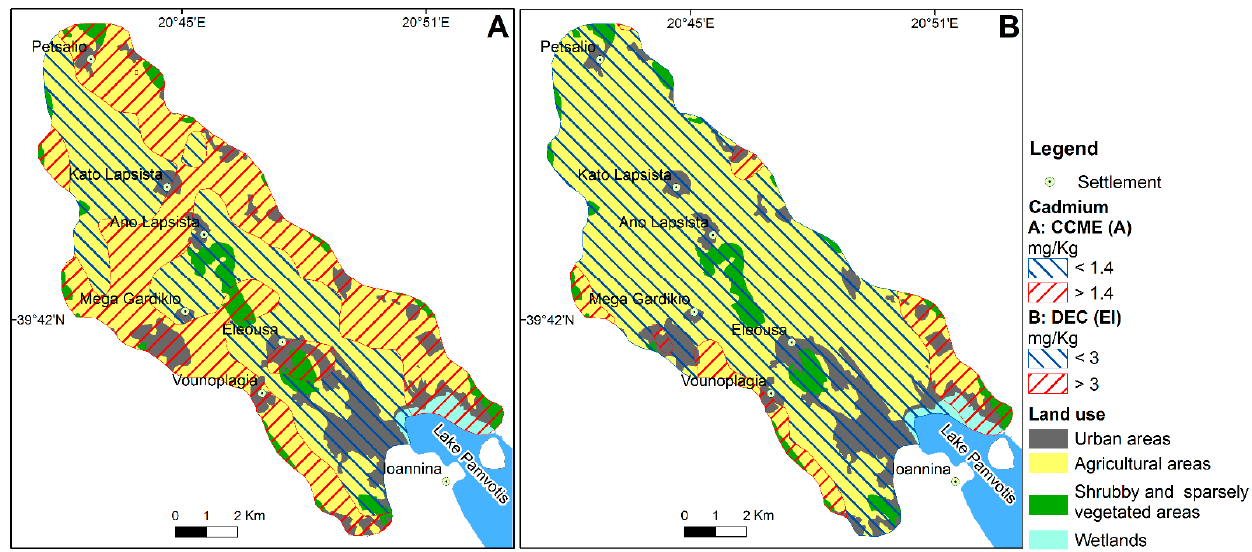
Figure 8. Suitability map comparing Cd content in soil of the study area to: ( A ) CCME (A); and ( B ) DEC (EI).